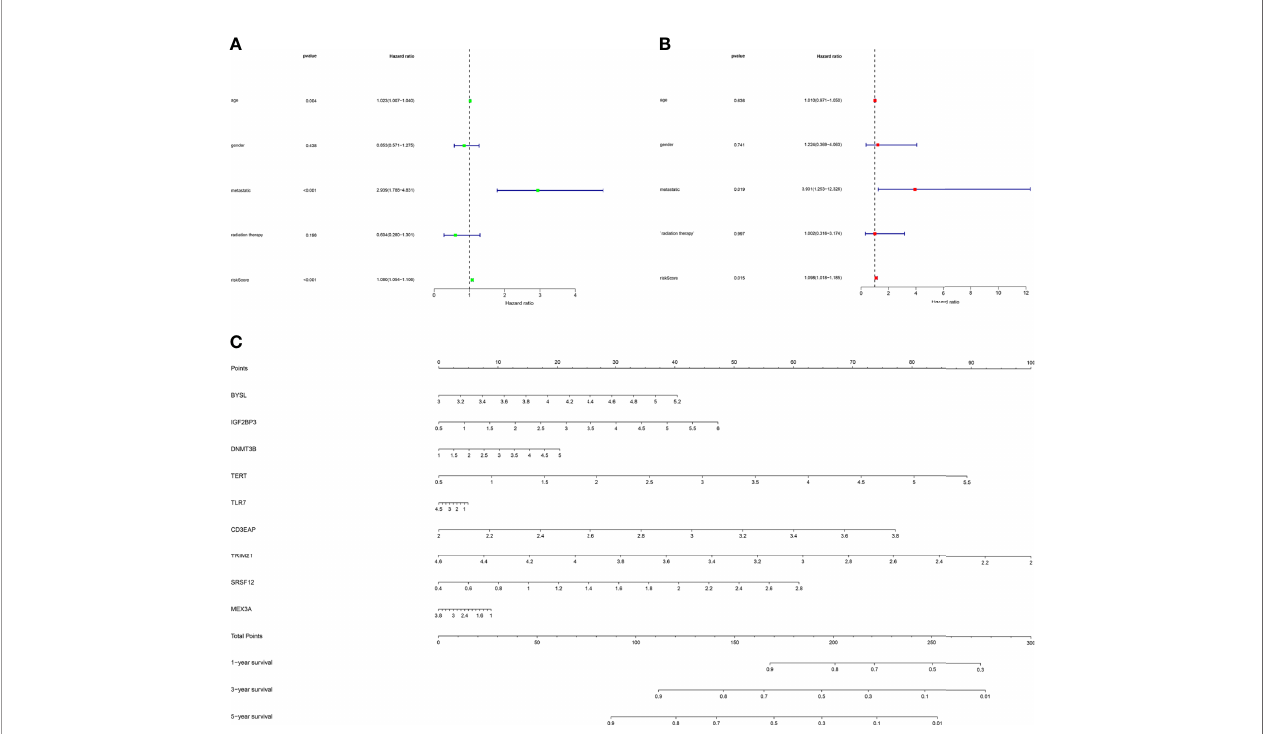
FIGURE 7 | The prognostic value of different clinical factors and nomogram construction. (A) Univariate analysis of different clinical factors of STS. (B) Multivariate analysis of different clinical factors of STS. (C) A nomogram containing the expression of 9 RBPs and risk score for the prediction of 1-, 3-, and 5-year overall survival in STS